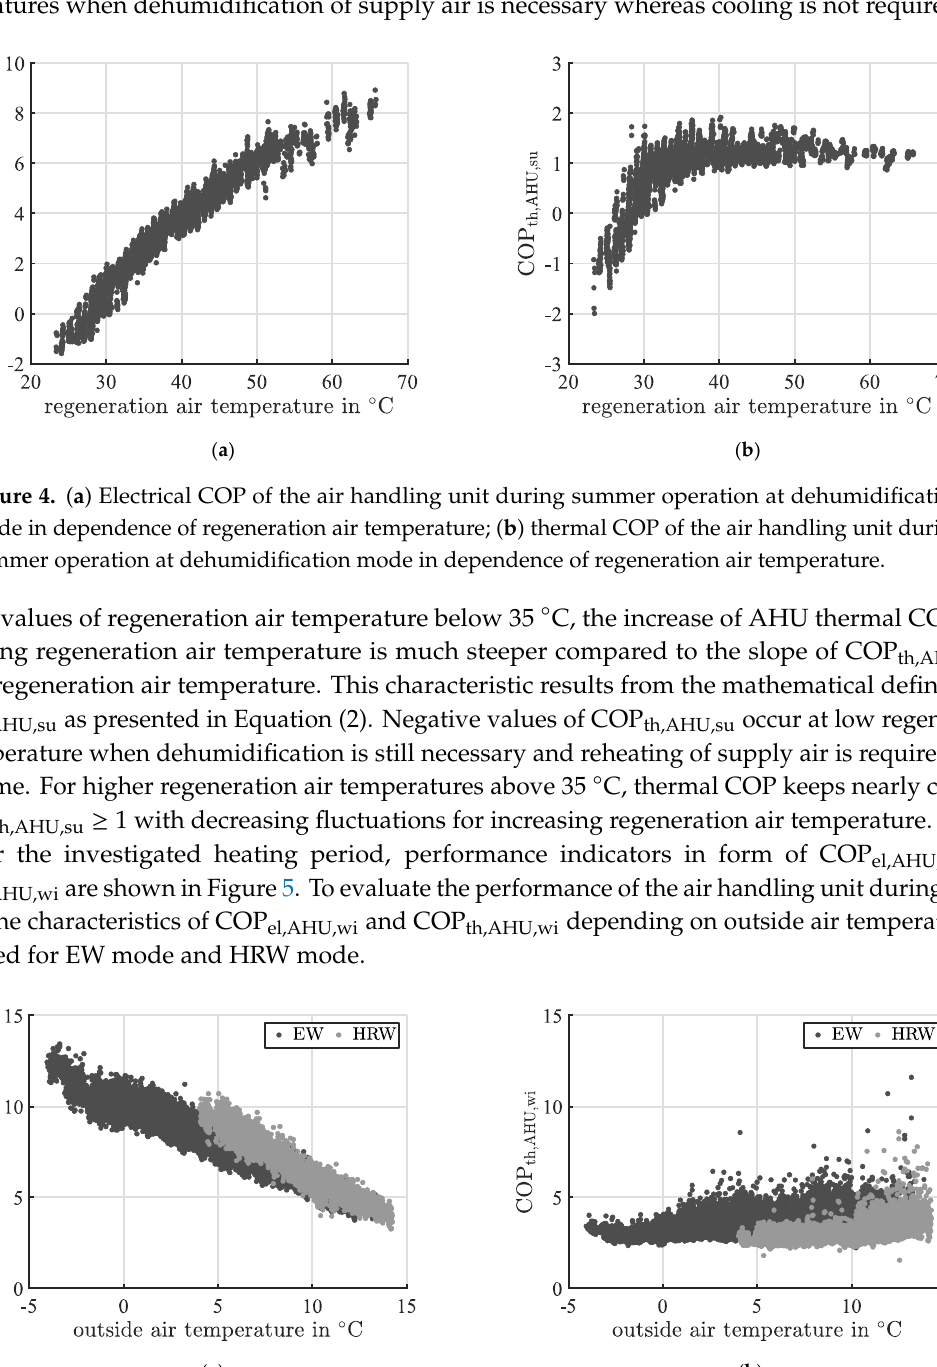
Figure 5. ( a ) Electrical COP of the air handling unit during winter operation in dependence of outside air temperature; ( b ) thermal COP of the air handling unit during winter operation in dependence of outside air temperature.